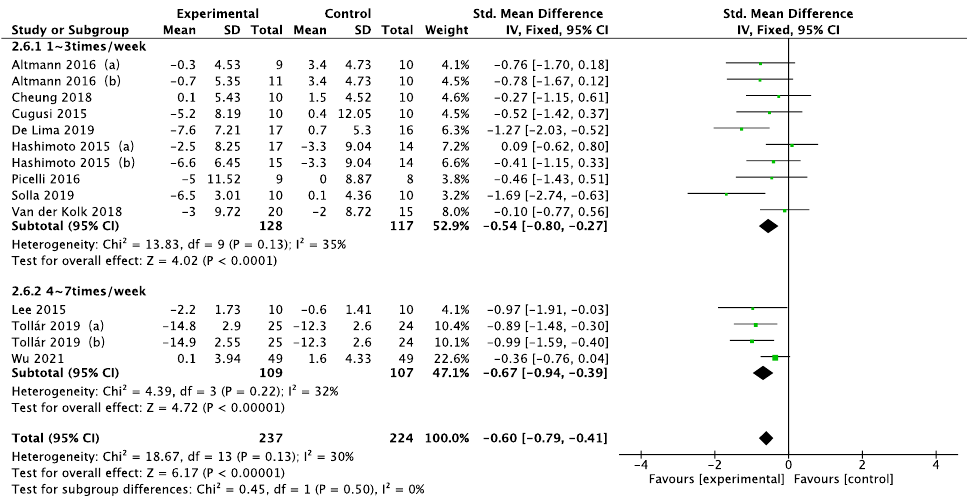
Figure 7. Subgroup analysis of intervention period [24,25,33 – 41].